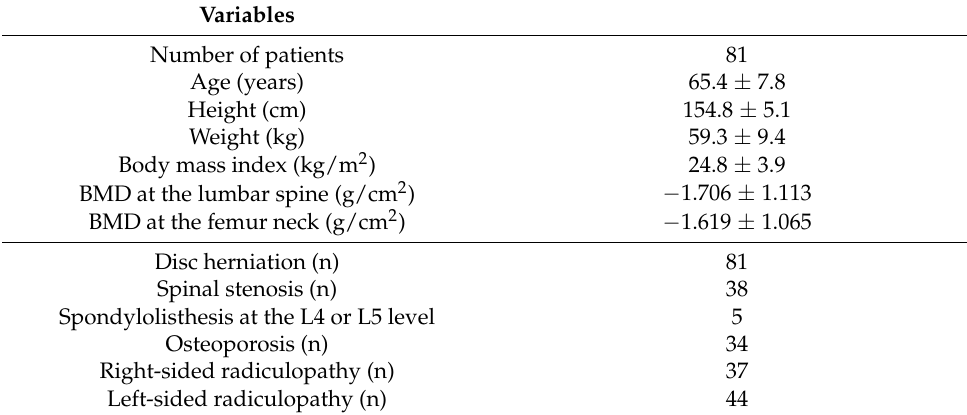
Table 1. Patients’ baseline